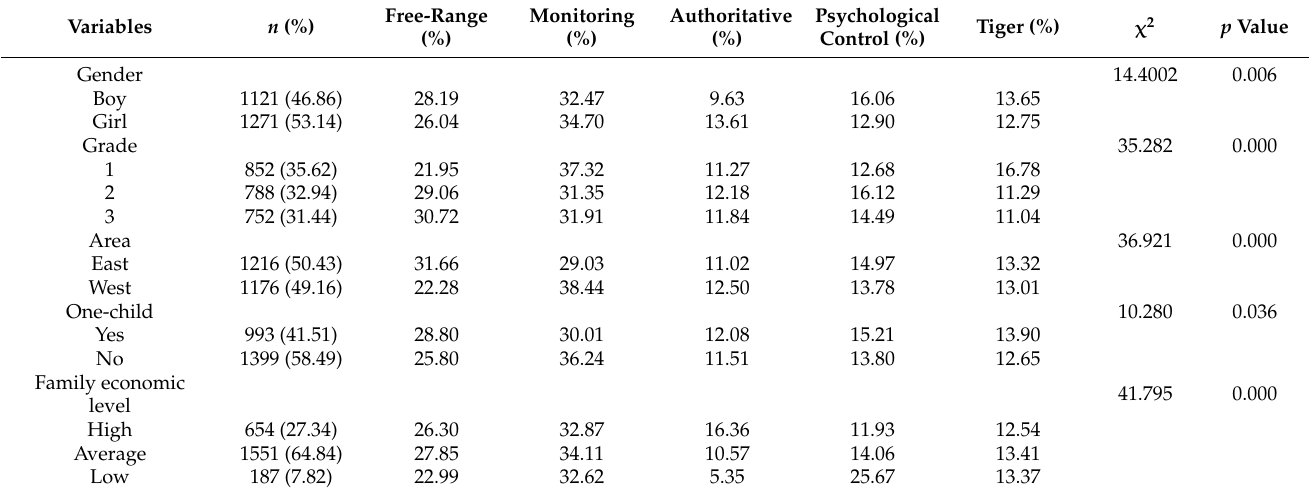
Table 4. Percentage distribution of respondents and percentage of parenting styles by variable ( n =